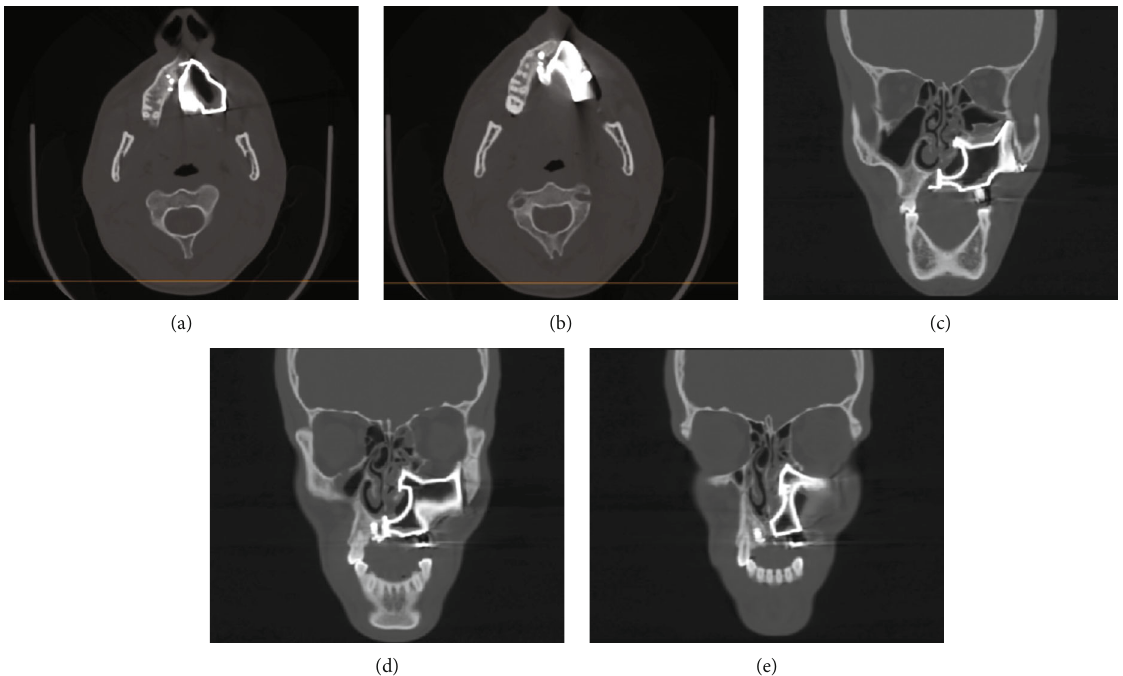
Figure 5: Computed tomography after 3 years of follow-up: (a, b) axial cuts and (c – e) coronal